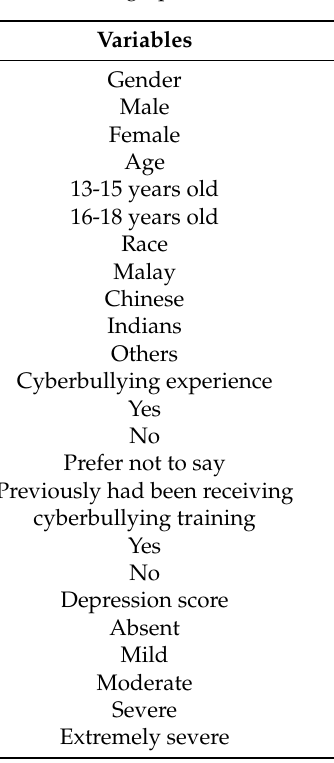
Table 2. Demographics ( n =